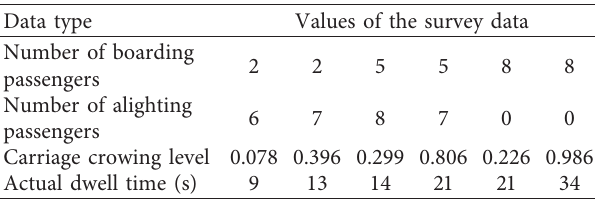
Table 8: Part of actual survey data of Route